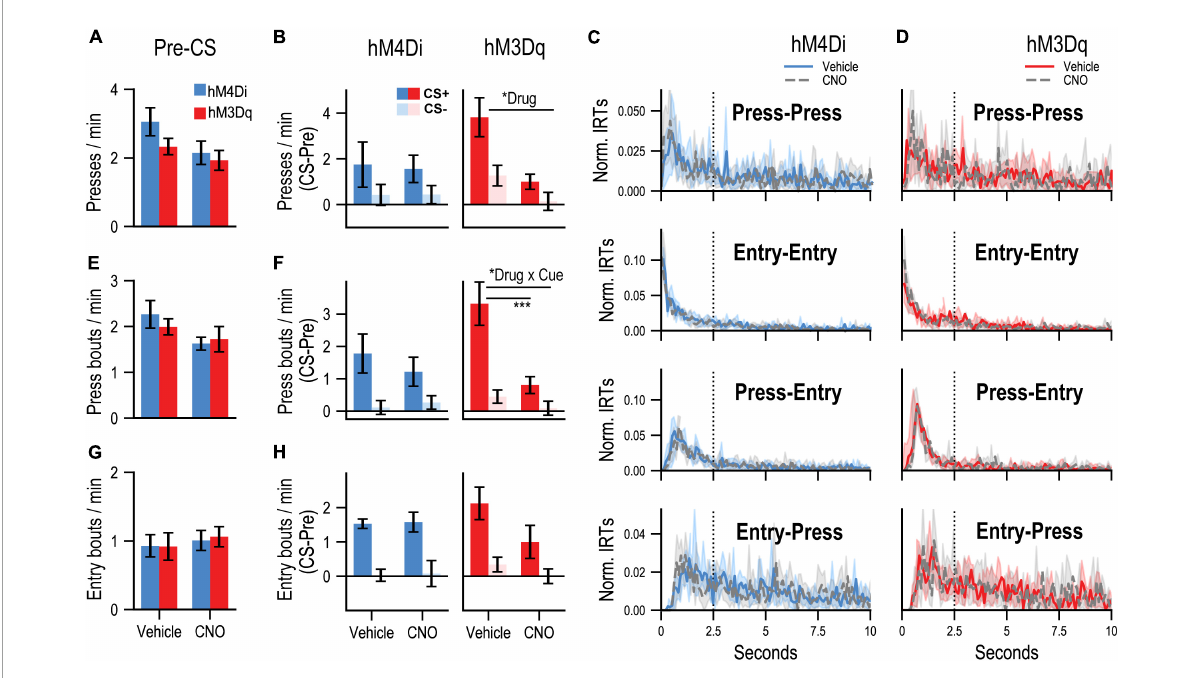
FIGURE2 (A) Mean rates (responses/min; ± SEM) of lever pressing during Pre-CS (baseline) periods of the PIT test. (B) Mean rates (responses/min) of cue-evoked (CS – Pre; ± SEM) lever pressing at test. (C,D) Normalized inter-response time (IRT) distributions ( < 10 s; central tendency ± 95% confidence intervals; plotted over 0.1-s bins) for four possible response sequences: Press-Press , Entry-Entry , Press-Entry , and Entry-Press . Dotted vertical line indicates the 2.5-s cutoff used for bout analysis (refer to main text). Data are separately plotted for hM4Di (C) and hM3Dq (D) AAV group and drug condition as indicated. (E) Mean rates (responses/min; ± SEM) of press bouts during Pre-CS (baseline) periods of the PIT test. (F) Mean rates (responses/min) of cue-evoked (CS – Pre; ± SEM) press bouts at test. (G) Mean rates (responses/min; ± SEM) of spontaneous (press-independent) food-port entry bouts during Pre-CS (baseline) periods of the PIT test. (H) Mean rates (responses/min) of cue-evoked (CS – Pre; ± SEM) food-port entry bouts at test. “Drug” refers to significant main effects of Drug, and “Drug × Cue” refers to a significant Drug × Cue interaction. The bar below indicates a significant simple effect of Drug for the CS+ condition. *p < 0.05, *** p <